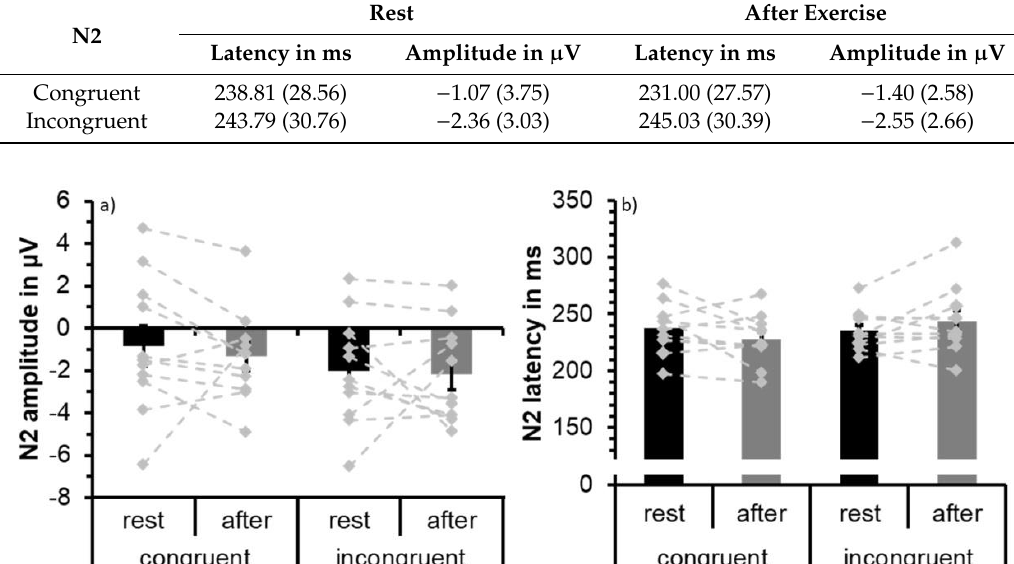
Figure 5. Mean N2 peak amplitude at rest (black) and after exercise (grey) trials in the first and second half of the dataset to visualize the test time × half interaction. Note: Negativity is plotted upward. Error bars depict standard error values.